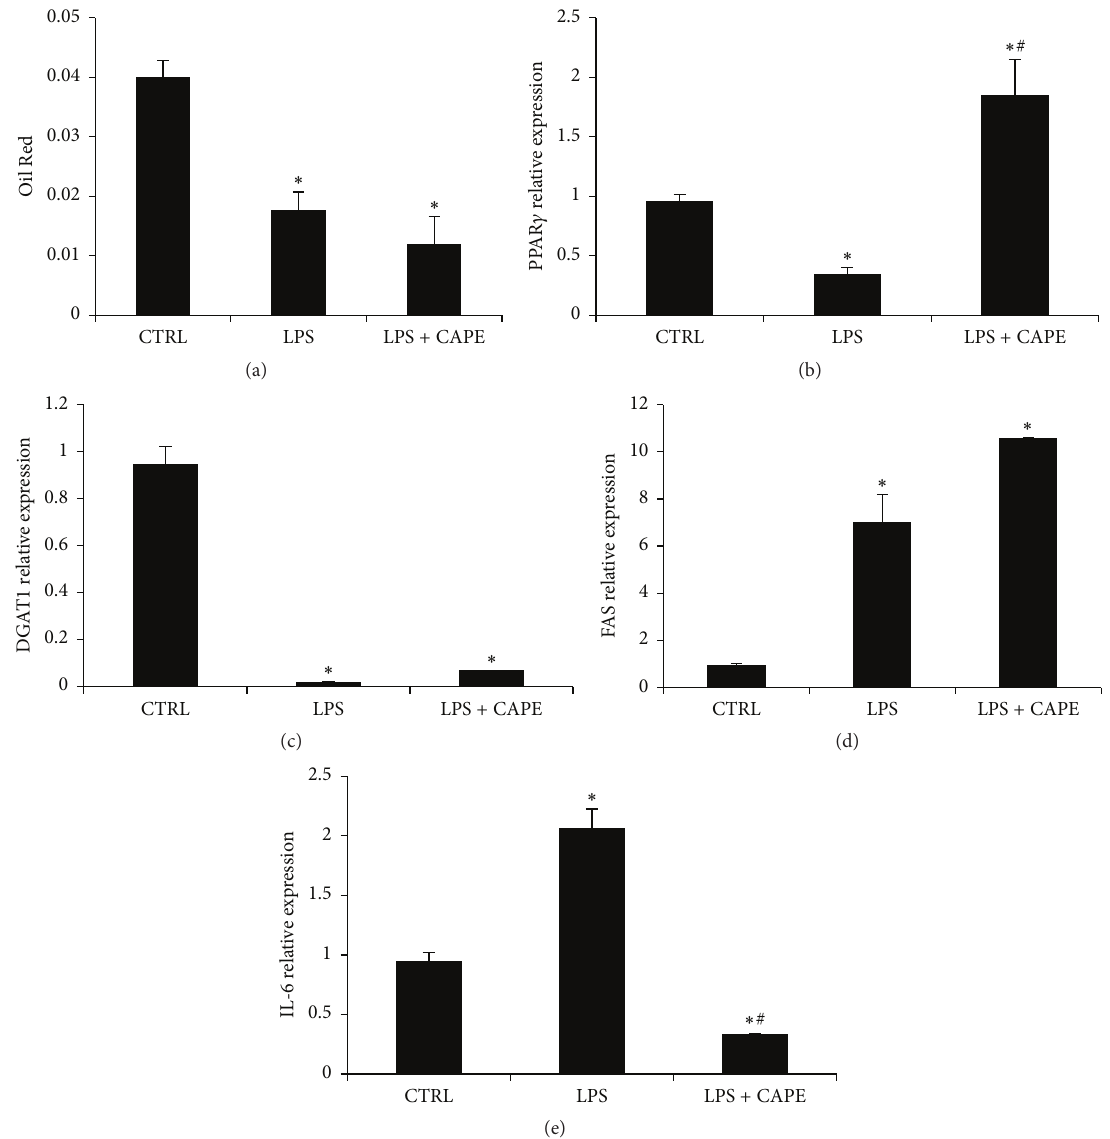
Figure 7: Effect of Cape (10 𝜇 M) and LPS on ASC-derived adipocytes. LPS was added 6 hrs before collecting cells at a dose of 1 ng/mL. Values represent the means ± SD of 4 experiments. ∗ 𝑝 < 0.05 , significant result versus differentiated cells (Ctrl). # 𝑝 < 0.05 , significant result versus